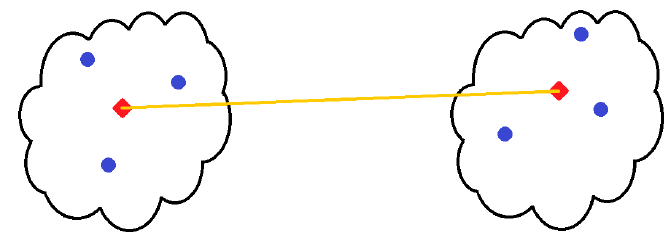
Figure 3. Centroids of clusters.